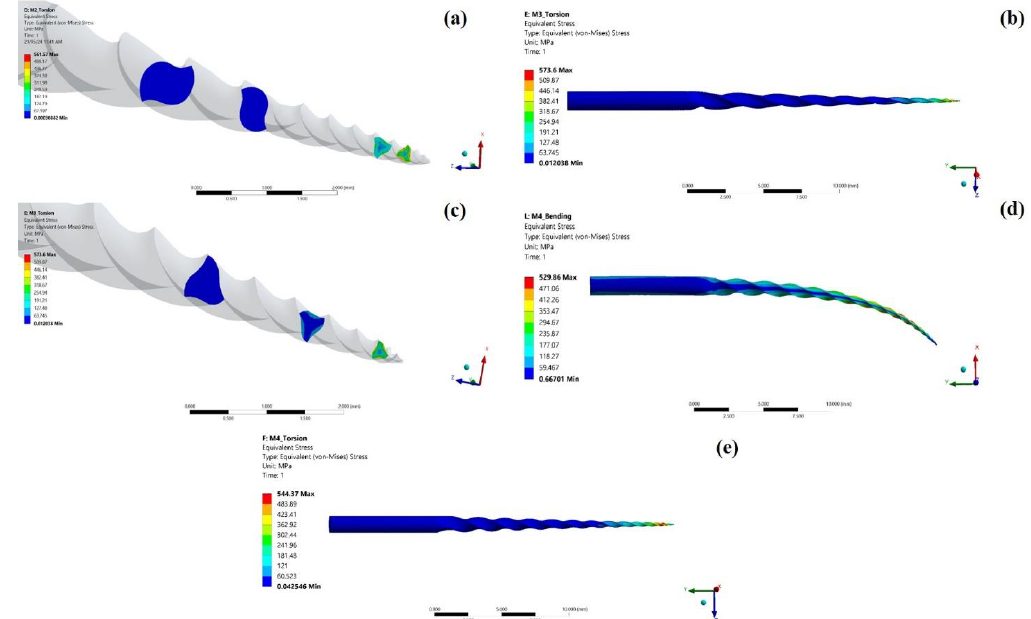
Fig. 5. Torsion distributes stresses a) in the one curve file (transverse view of the file), b) in the Edge Endo file (longitudinal view of the file), c) in the Edge Endo file (longitudinal view of the file), d) bending stresses in Vortex blue file (longitudinal view of the file) and e) distribute torsion stresses in the Vortex blue file (File length view)